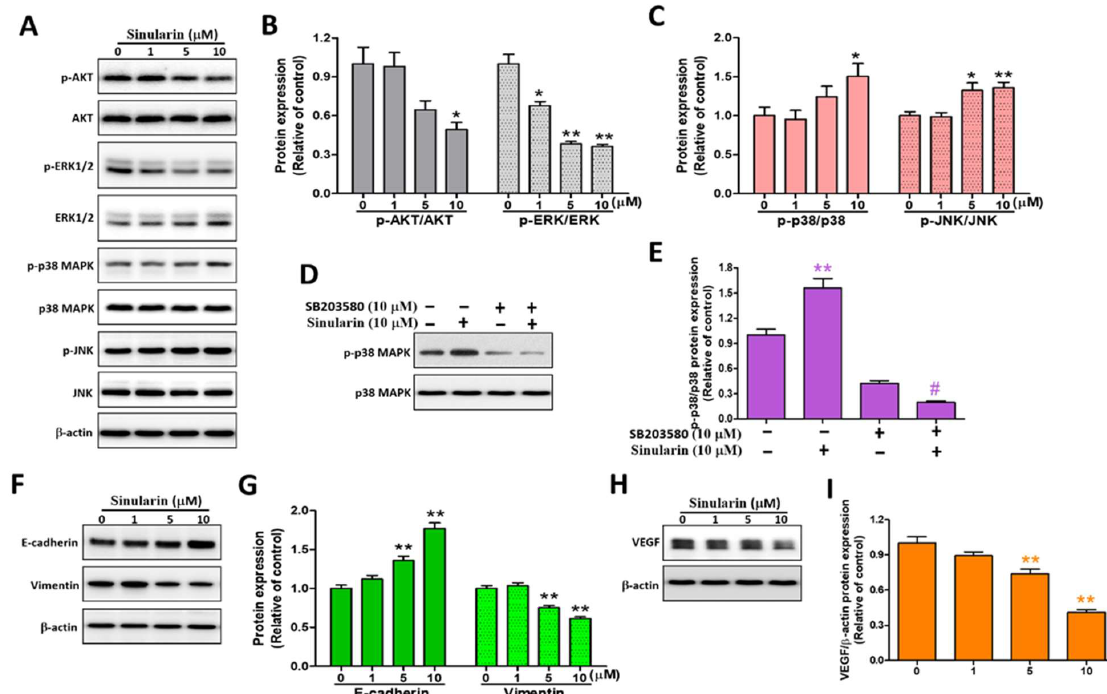
Figure 6. The effects of sinularin on AKT, MAPKs, E-cadherin, vimentin, and VEGF protein expression levels in SK-HEP-1 cells. SK-HEP-1 cells were treated with different concentrations of sinularin for 24 h. ( A ) The cell lysates were subjected to Western blot analyses with antibodies against p-AKT, AKT, p-ERK1/2, ERK1/2, p-p38 MAPK, p38 MAPK, p-JNK, and JNK and the internal control β-actin. Full, uncropped Western blot gels are shown in Supplementary Figure S3A. ( B ) p-AKT, AKT, p-ERK1/2, and ERK1/2 protein levels, quantified by densitometry analysis using ImageJ software after being normalized with the β-actin level. ( C ) p-p38 MAPK, p38 MAPK, p-JNK, and JNK levels, quantified by densitometry analysis using ImageJ software after being normalized with the β-actin level. ( D ) Pre-treatment with SB203580 reversed sinularin-induced p38 protein level. The cell lysates were subjected to Western blot analyses with antibodies against p-p38 MAPK and p38 MAPK. Full, uncropped Western blot gels are shown in Supplementary Figure S3B. ( E ) p-p38 MAPK and p38 MAPK protein levels, quantified by densitometry analysis using ImageJ software. ( F ) The cell lysates were subjected to Western blot analyses with antibodies against E-cadherin, vimentin, and β-actin. Full, uncropped Western blot gels are shown in Supplementary Figure S3C. ( G ) E-cadherin and vimentin protein levels, quantified by densitometry analysis using ImageJ software after being normalized with the β-actin level. ( H ) The cell lysates were subjected to Western blot analyses with an anti-VEGF antibody and β-actin. Full, uncropped Western blot gels are shown in Supplementary Figure S3D. ( I ) VEGF protein levels quantified by densitometry analysis using ImageJ software after being normalized with the β-actin level. Each bar represents the mean ± SE of three independent experiments. The results were analyzed using Stu- dent’s t -test and ANOVA to determine the significance, in which * p <0.05, ** p <0.01, and # p <0.01, relative to the 10 μM sinularin-treated group.